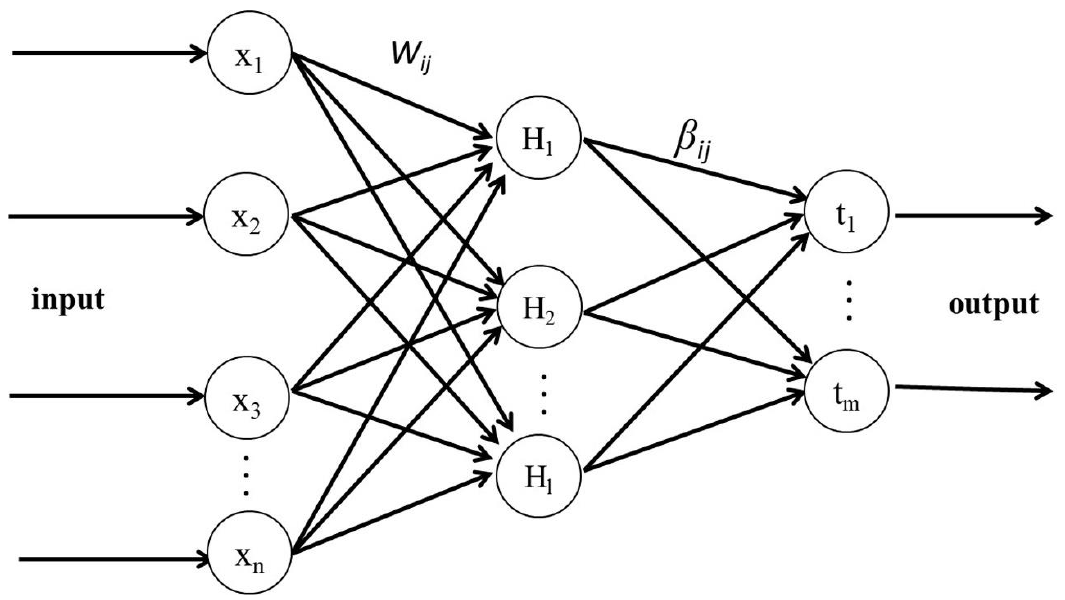
Figure 2. Architecture of extreme learning machine.